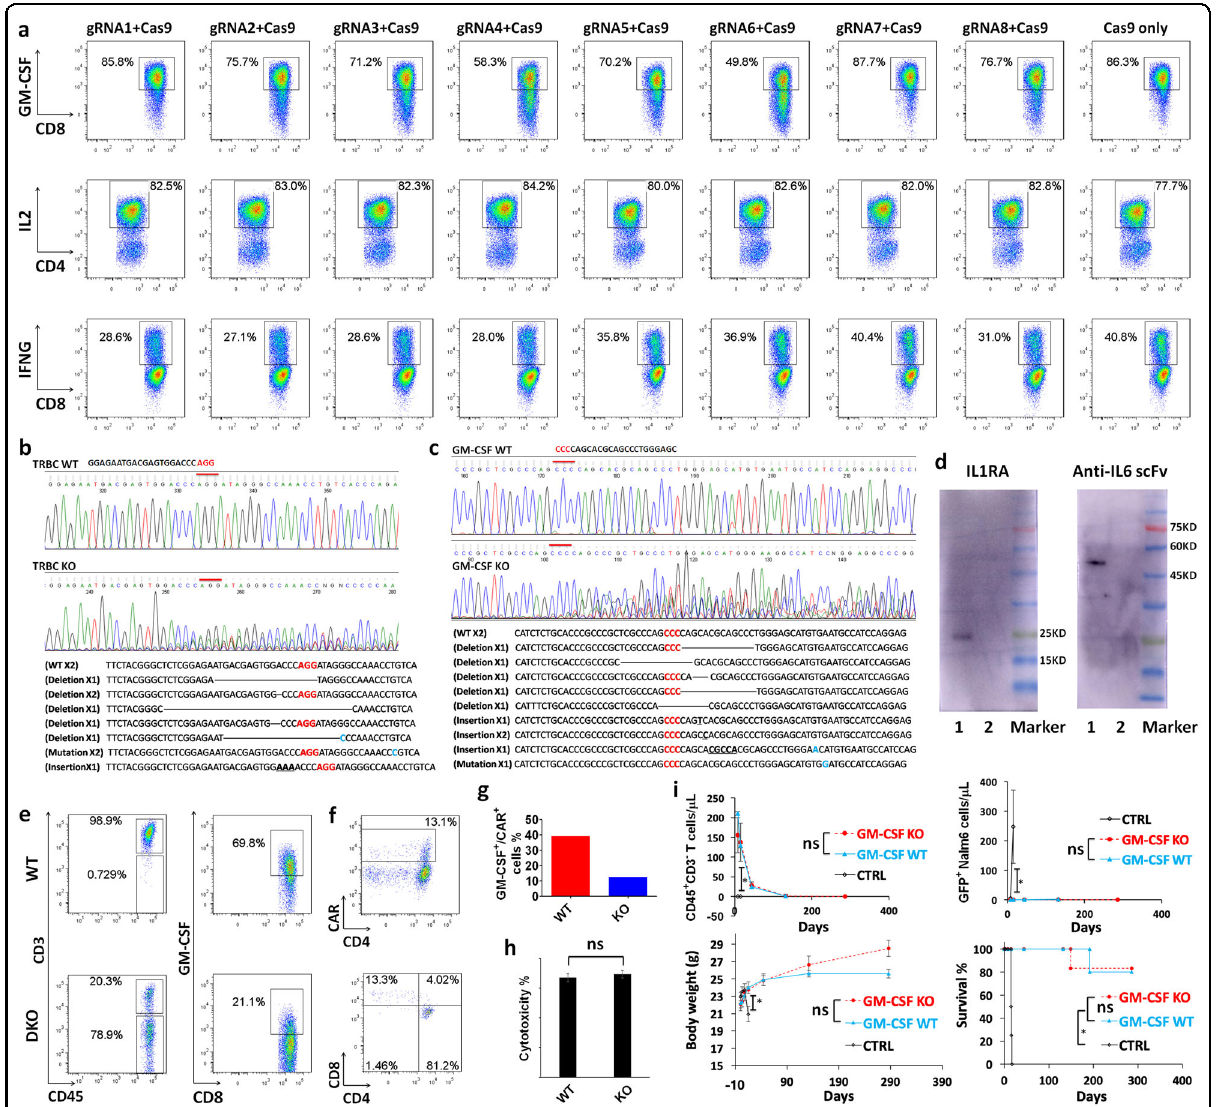
Fig. 2 Screening of sgRNA for CRISPR-edited KO of GM-CSF and anti-CD19 CART-aIL6/IL1RA with GM-CSF/TCR KO in xenograft study. a sgRNA candidates targeting the fi rst exon of GM-CSF were electroporated with Cas9 protein in normal donor T cells and subsequently tested for cytokine expression via intracellular staining. b , c Normal donor T cells were engineered with CRISPR/Cas9 RNP for TCR KO ( b ) or GM-CSF KO ( c ). The edited T cells were then collected for PCR ampli fi cation of a region spanning the PAM (NGG) site targeted by sgRNA. Ampli fi ed PCR products were Sanger sequenced. PCR products ampli fi ed from edited T cells were also ligated to a pUC-19 vector and subsequently transformed into competent cells. Single colonies were picked up for preparation of plasmid DNA, which were then Sanger sequenced to reveal the genetic alteration after CRISPR editing. d Anti-CD19 CART co-expressing IL1RA and anti-IL6 scFv fused to GST/His tag were cocultured with Nalm6-GFP cells and the culture supernatant was collected for WB analysis with antibodies against human IL1RA and His tag (Lane 1). Non-transduced T cells were included as control (Lane 2). e , f Normal donor T cells were engineered with CRISPR/Cas9 RNP for GM-CSF/TCR KO and transduced with lentivector encoding 2nd generation 41BB ζ CAR and anti-IL6 scFv and IL1RA: e the KO ef fi ciency of TCR and GM-CSF; f CAR frequency and CD4/CD8 subpopulations in edited CD3 – T cells. g Anti-CD19 CART cells with GM-CSF KO or WT were stimulated with Nalm6-GFP cells and analyzed by intracellular staining. The representative result of two independent experiments was shown. h Cytotoxicity of anti-CD19 CART-aIL6/IL1RA with GM-CSF/TCR KO or only TCR KO. Statistical analysis by Student ’ s t test showed no signi fi cance (ns). i Antitumor ef fi cacy of anti-CD19 CART-aIL6/IL1RA with GM-CSF/TCR KO in xenograft model. Statistical analysis by Student ’ s t test was conducted for body weight (BW), GFP + Nalm6 cell number, and CD45 + CD3 – T cell number, with Log-Rank test for survival curves. * Indicates statistical signi fi cance with P < 0.05 and ns indicates no signi fi